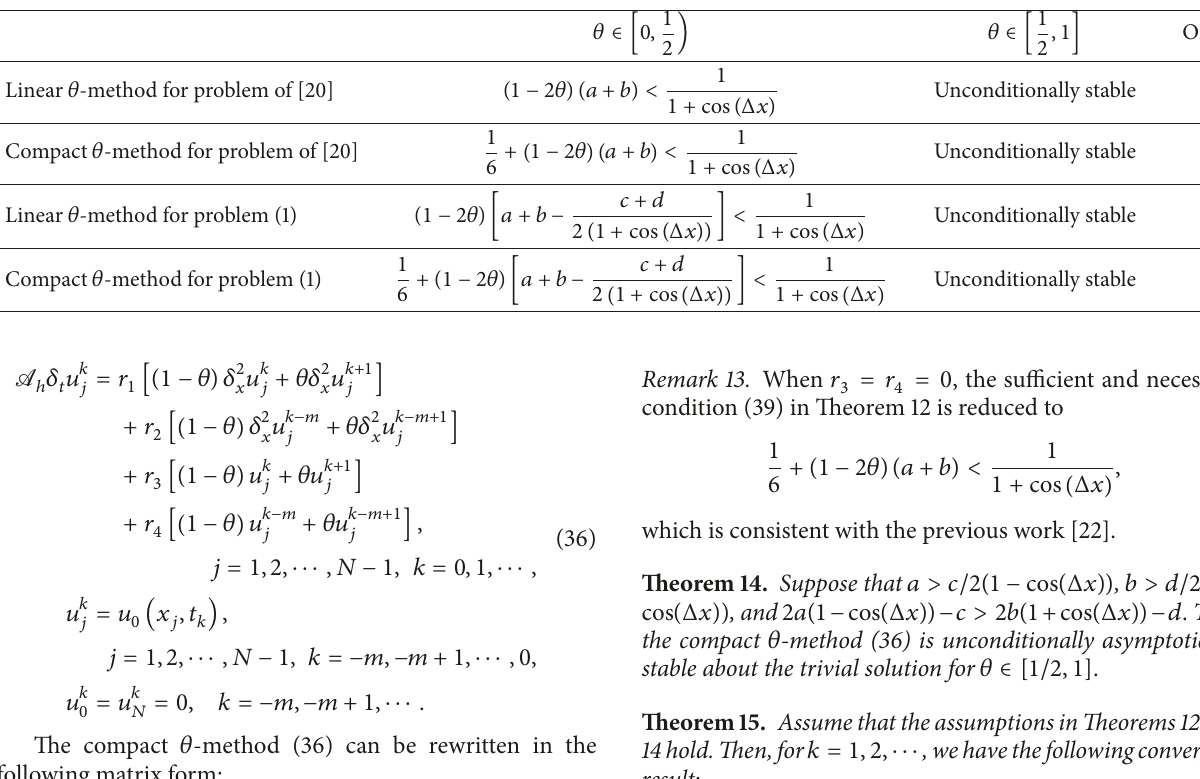
Table 1: Stability and convergence order of different methods.